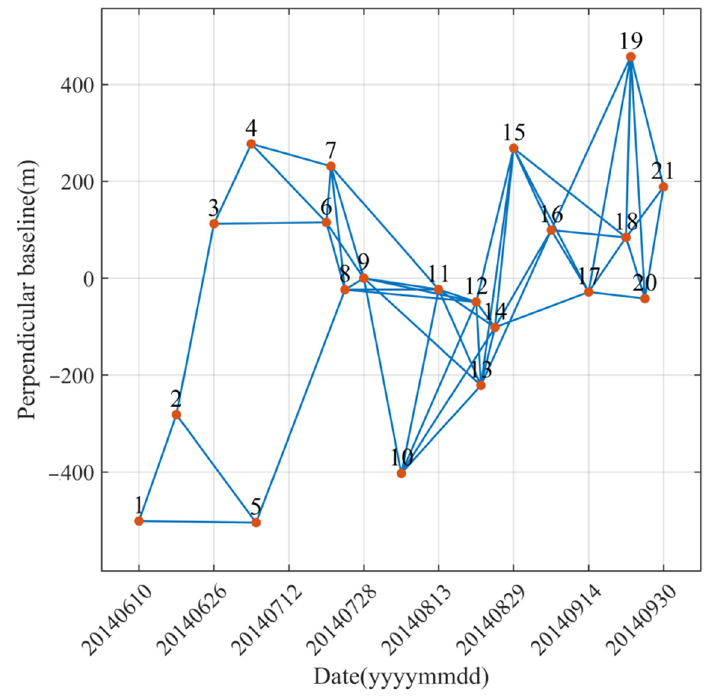
Figure 4. Spatiotemporal baselines of interferograms.